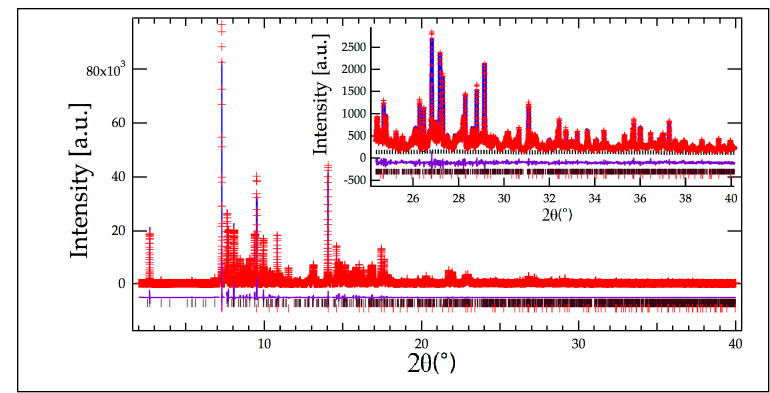
Figure 2. Fit to X-ray data; observed and calculated data are red crosses and the continuous blue line, respectively. The dotted and solid black curves represent the background and the difference between observed and calculated data, respectively.